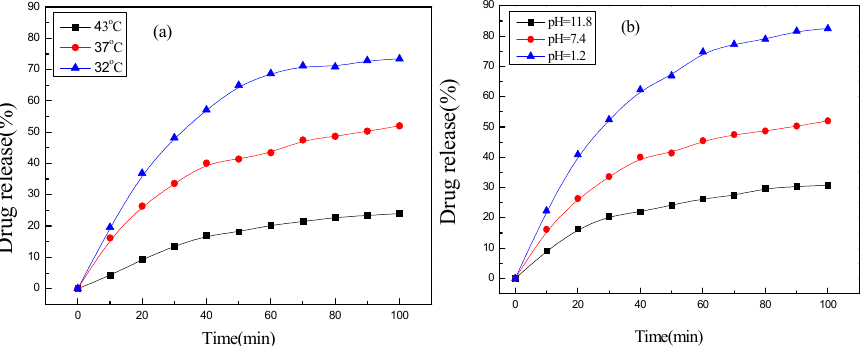
Figure 10. The cumulative release curves of bovine serum albumin (BSA) at different temperatures ( a ) and different pH ( b ).